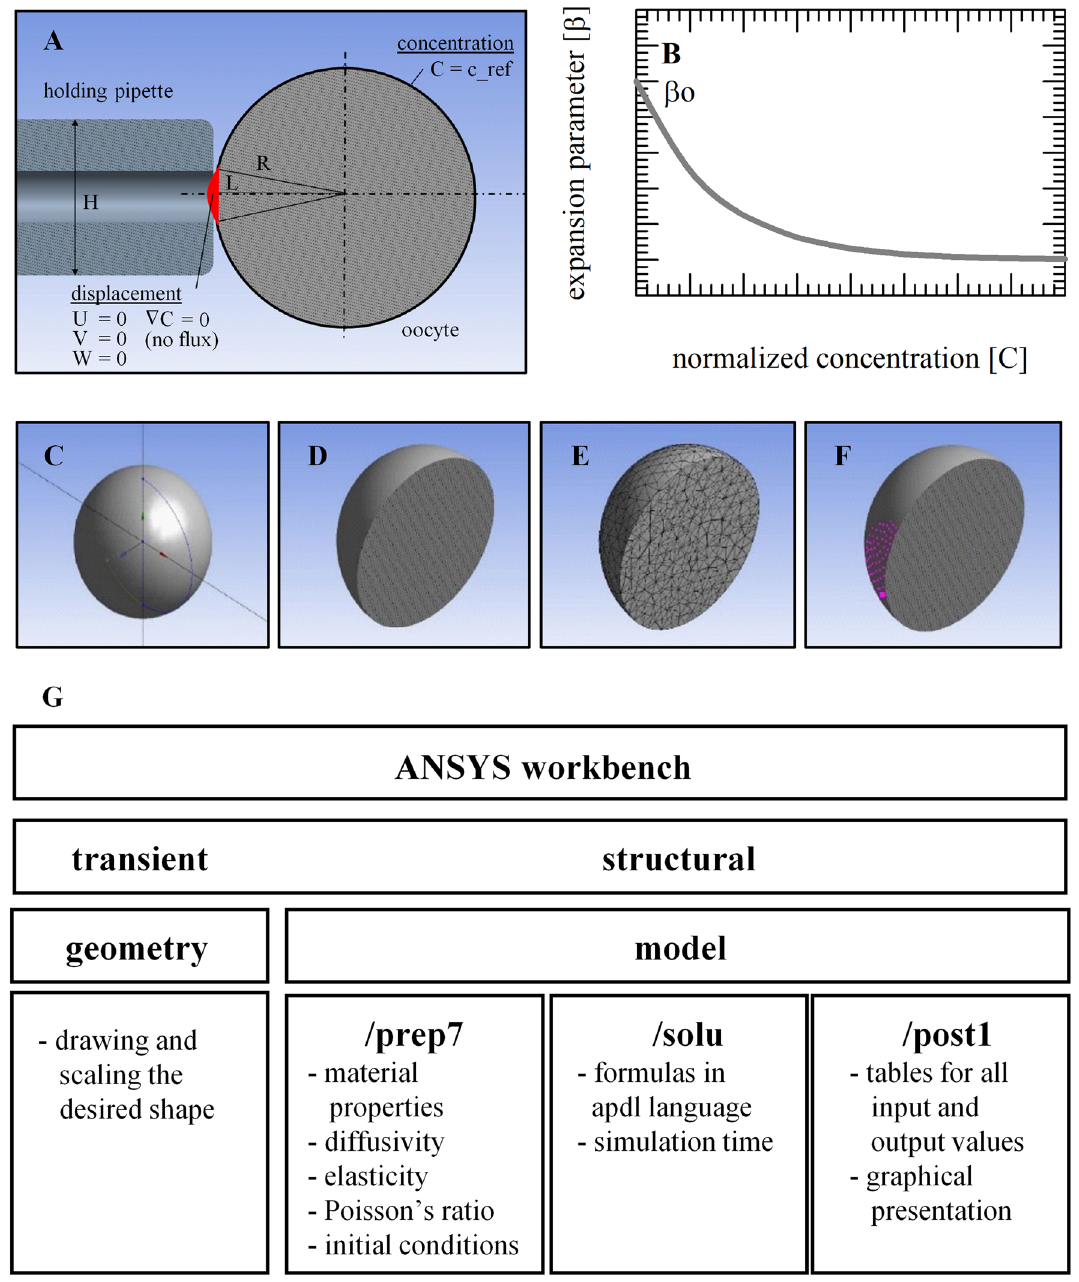
parameter versus the normalized concentration ( B ). In panels ( C ‒ F ) are illustrated the different views as